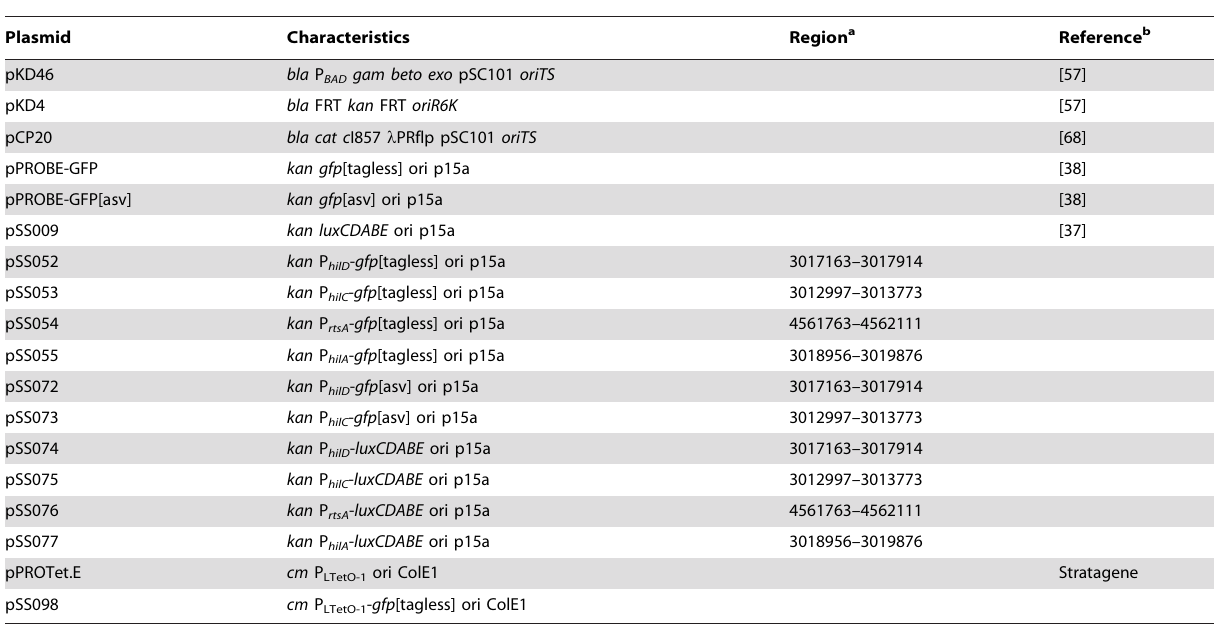
Table 2. List of plasmids used in this study.